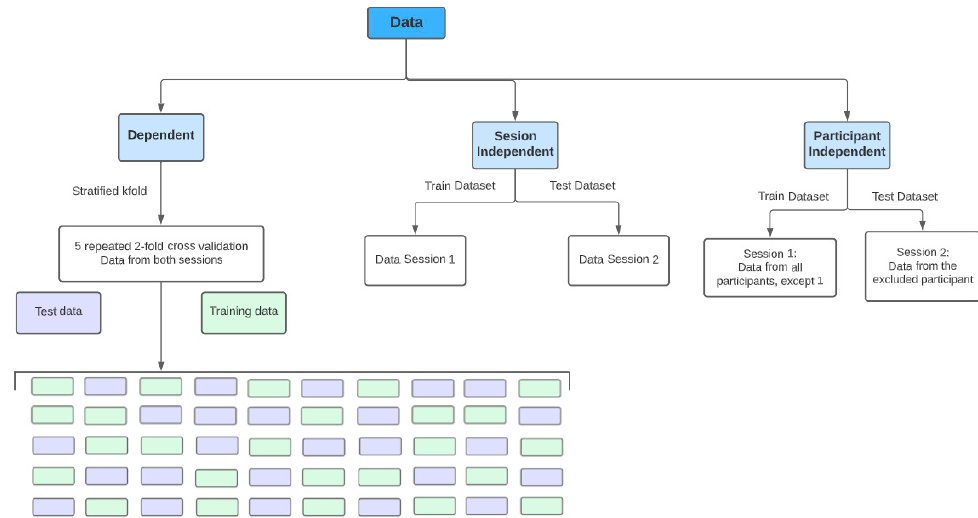
Figure 6. Scheme of the different approaches to divide data for model learning.